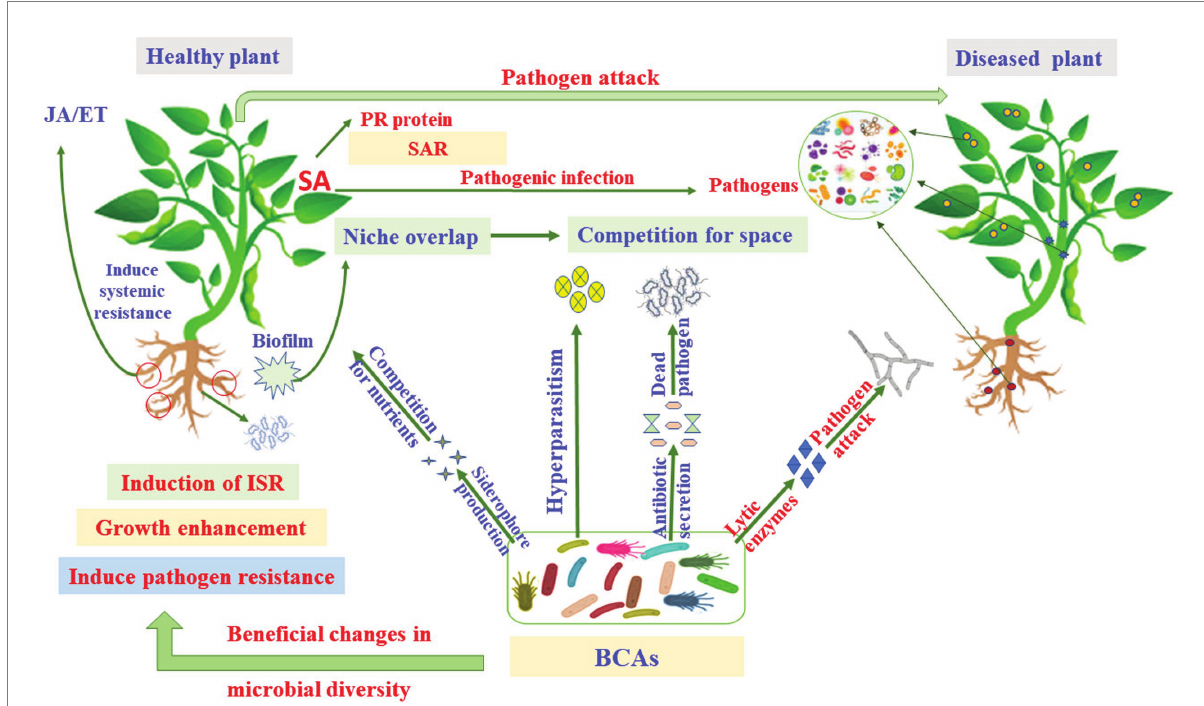
FIGURE 4 Pathways and modes of action of microbial biocontrol agents (MBCAs). ET, ethylene; ISR, induced systemic resistance; JA, jasmonic acid; PR, pathogenesis-related; SA, salicylic acid; SAR, systemic acquired